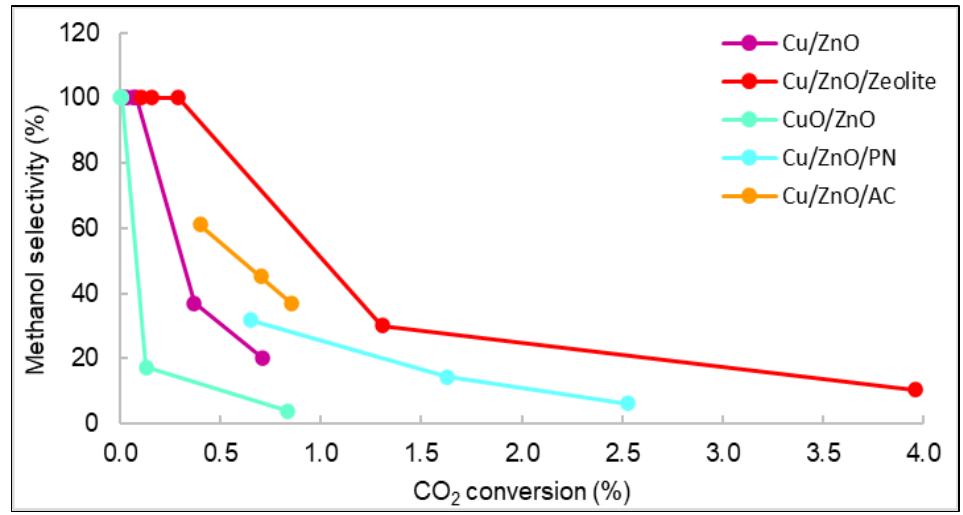
Figure 9. Representation of the selectivity vs. carbon dioxide conversion of all catalysts.